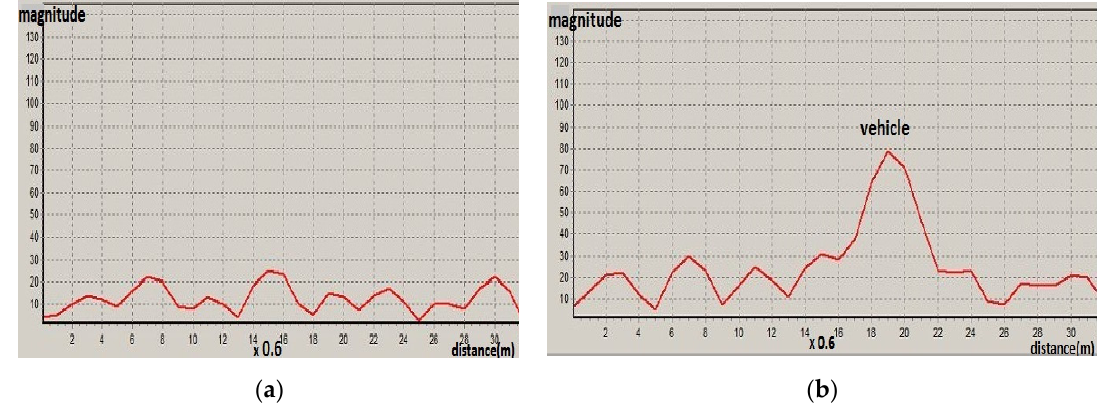
Figure 14. Threshold selection for traffic experimental tests. ( a ) A snapshot of FFT magnitude of environment noise within each lane with no vehicles; ( b ) A snapshot of FFT magnitudes of both environment noise and vehicle signal within each lane.